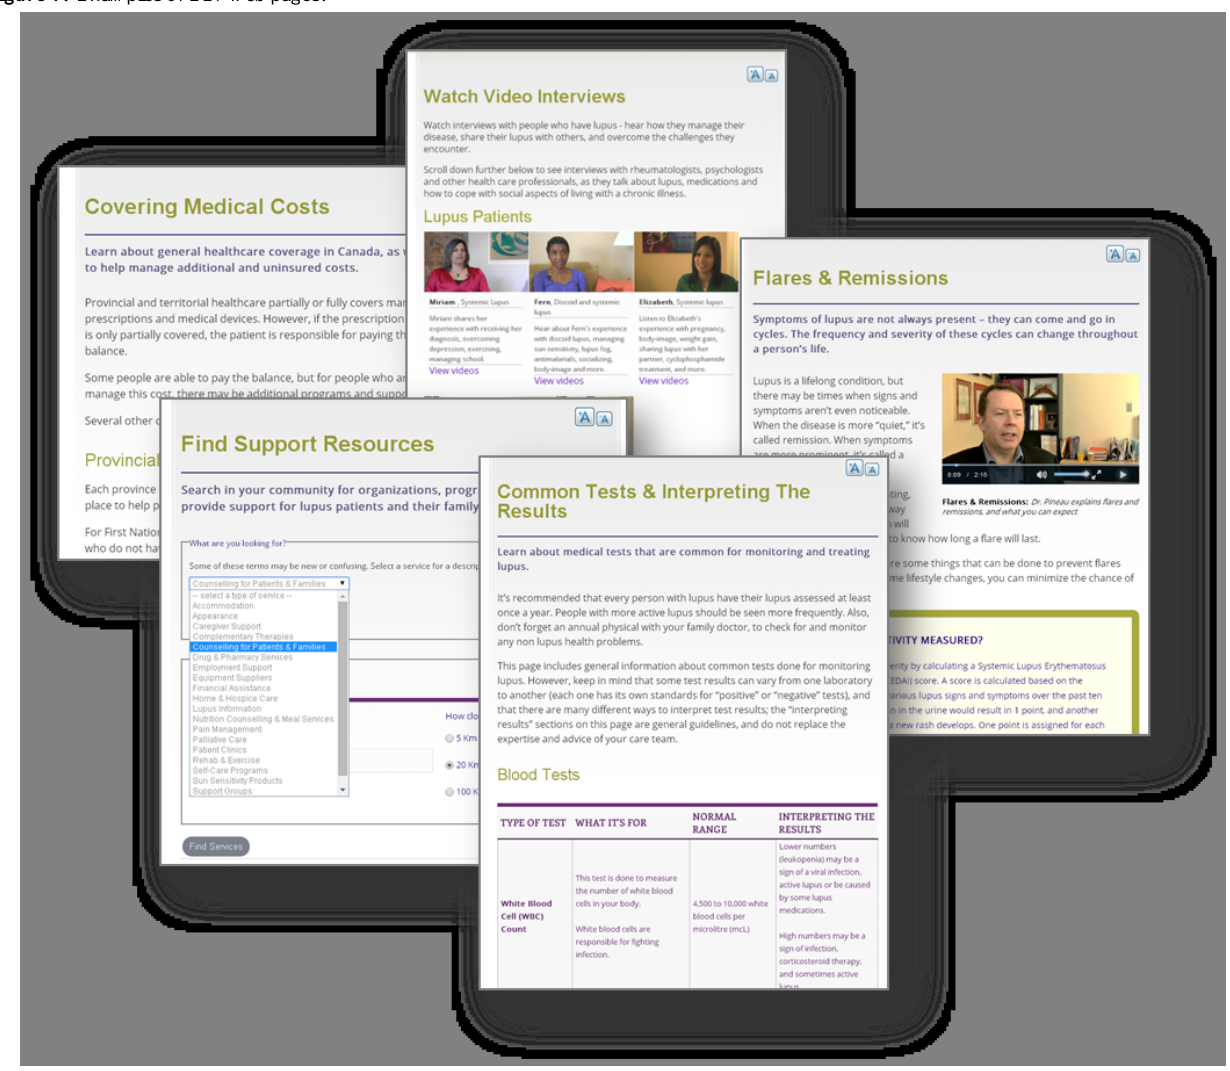
Figure 1. Examples of LIN web